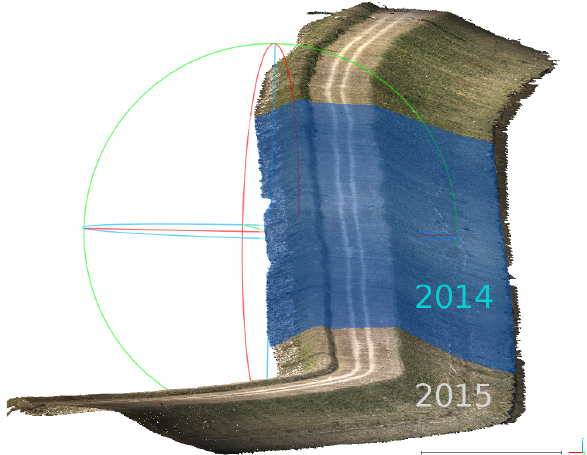
Figure 9: Perspective view over the colored pointcloud derived from the 2015 UAV acquisition. The blue section highlights the 2014 acquisition